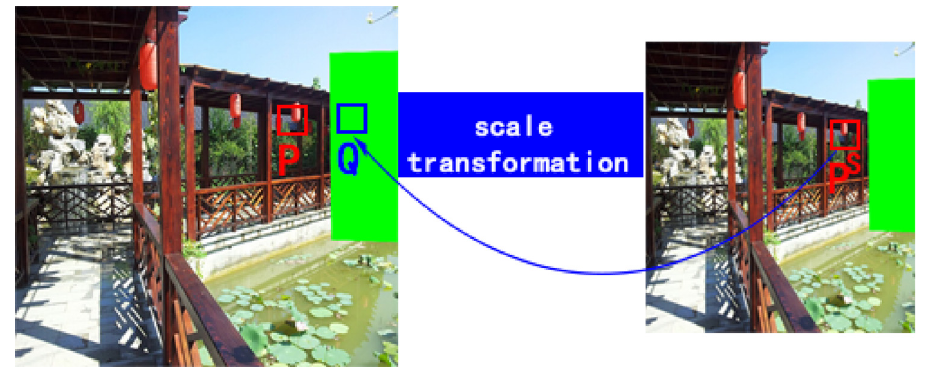
Fig 6. Scale transformtion for image